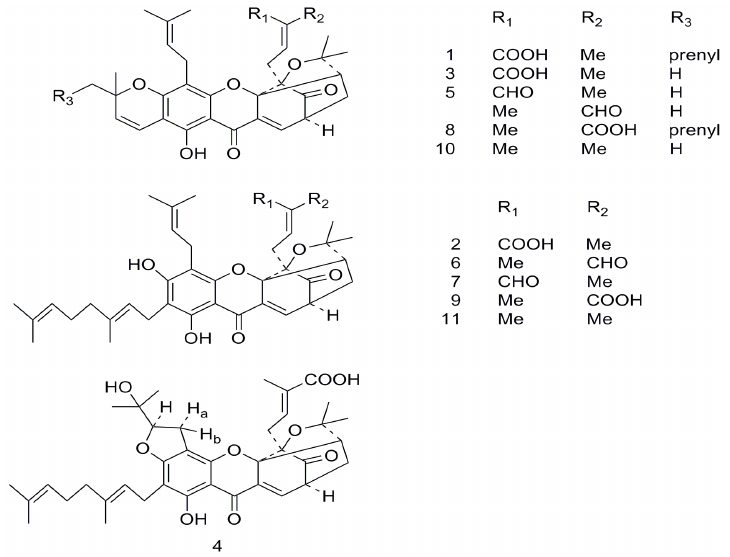
Figure 1. The structures of caged polyprenylated xanthones 1 – 11 isolated from G. hanburyi.